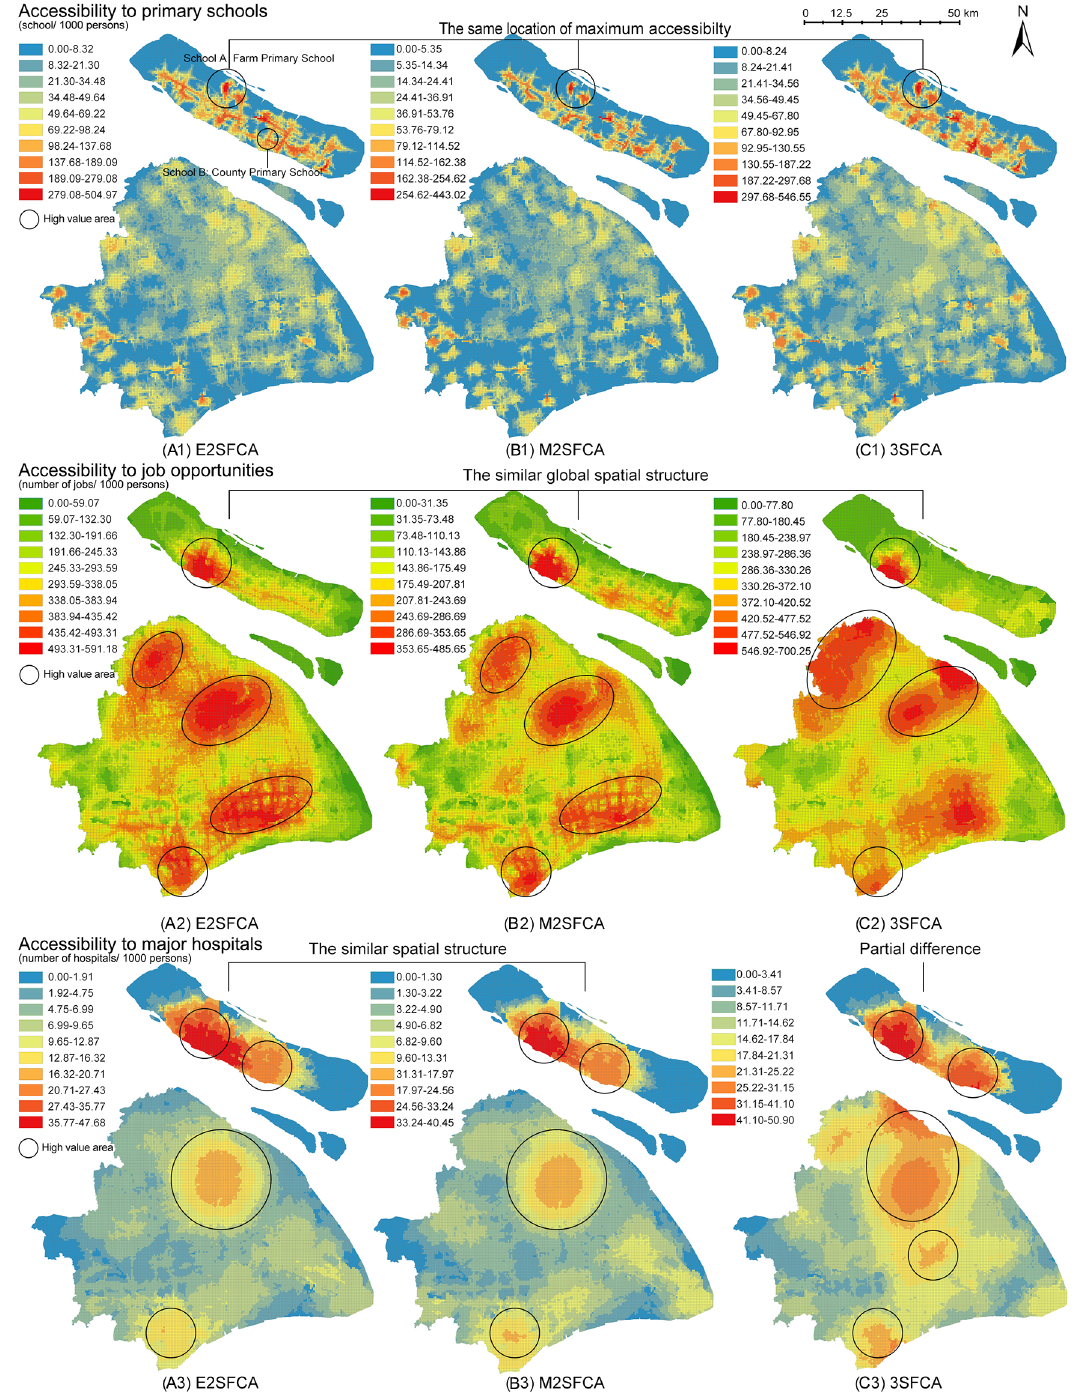
Figure 4. Access ratios as the sum of weighted supply-demand ratios ( A R i ). Three floating catchement area (FCA) metrics generate similar spatial distribution of accessibility according to resources. (A) enhanced two-step FCA (E2SFCA), (B) modified two-step FCA (M2SFCA), and (C) three-step FCA Although weighted ratios eliminate the effect of the decay coefficient values, the validity of model stability across model types remains contentious. In Figure 4, the nuances between three FCA methods exist in partial districts and at the local level. Those subtle differences make it difficult to verify the intended characteristics of FCA methods and further lead to the dispute over the necessity of improvements. On the contrary, Figure 3 visualises the different model improvements in